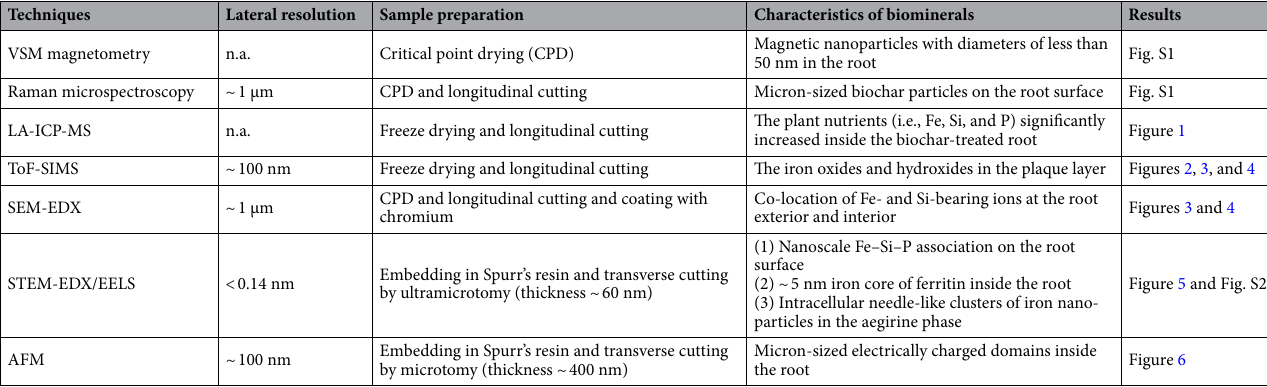
Table 1. Characterization techniques for biominerals formed in the exterior and interior surface of biochar- treated root at micron- and sub-micron